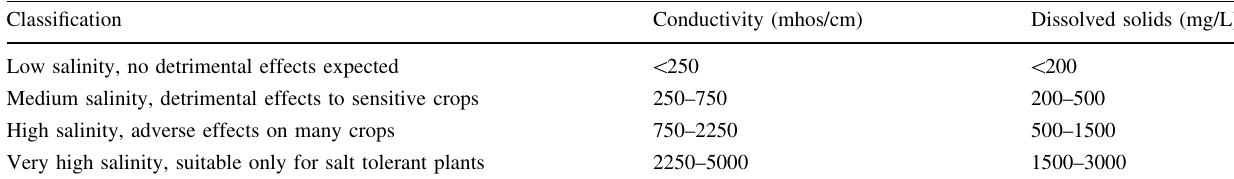
Fig. 2 Piper Diagram of: a Kakareza and b Dehnu Table 4 Classification of water salinity